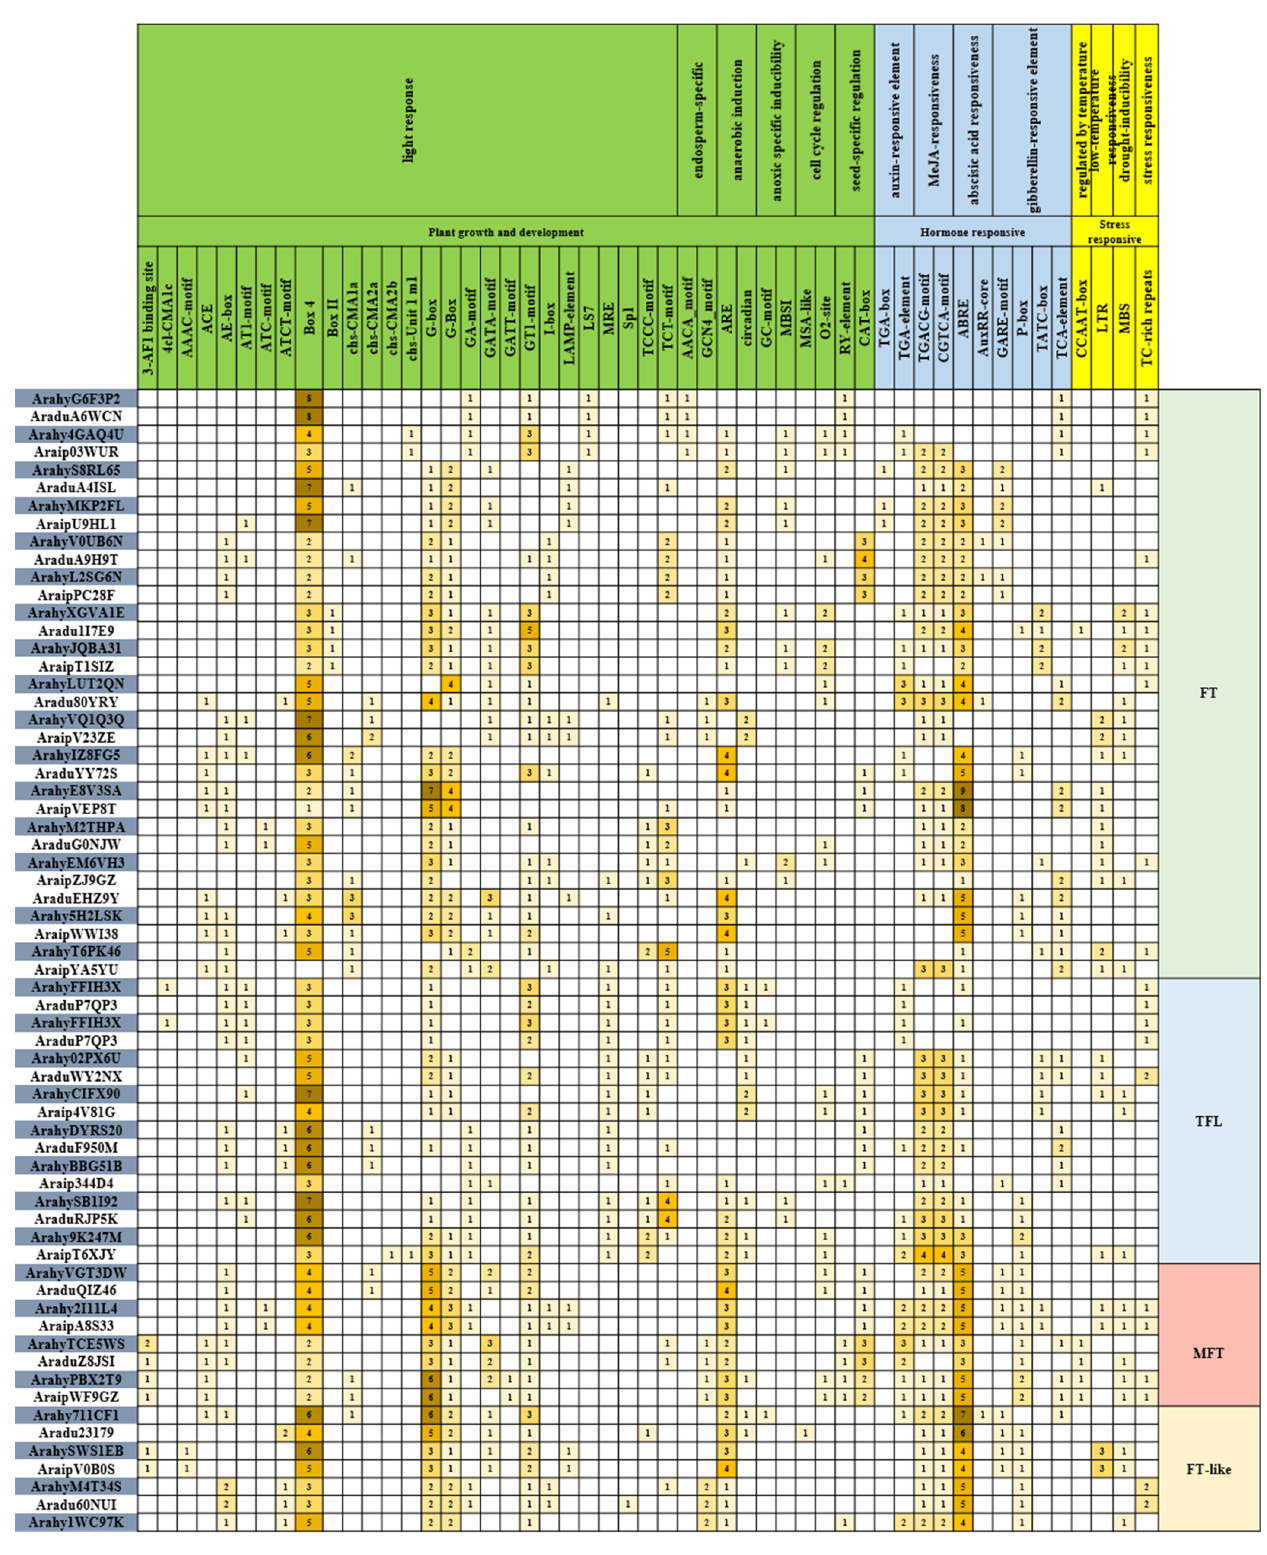
Figure 6. Analysis of cis ‐ acting elements based on 2kb upstream of PEBP genes. The number of cis ‐ acting elements with various functions were counted. The number of cis ‐ acting elements from 1 to 9 are marked with different depths of yellow back ‐ ground.